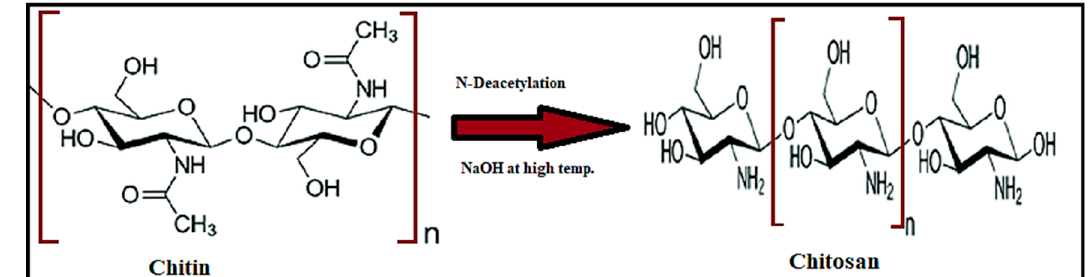
Figure 3. Structure of chitosan.